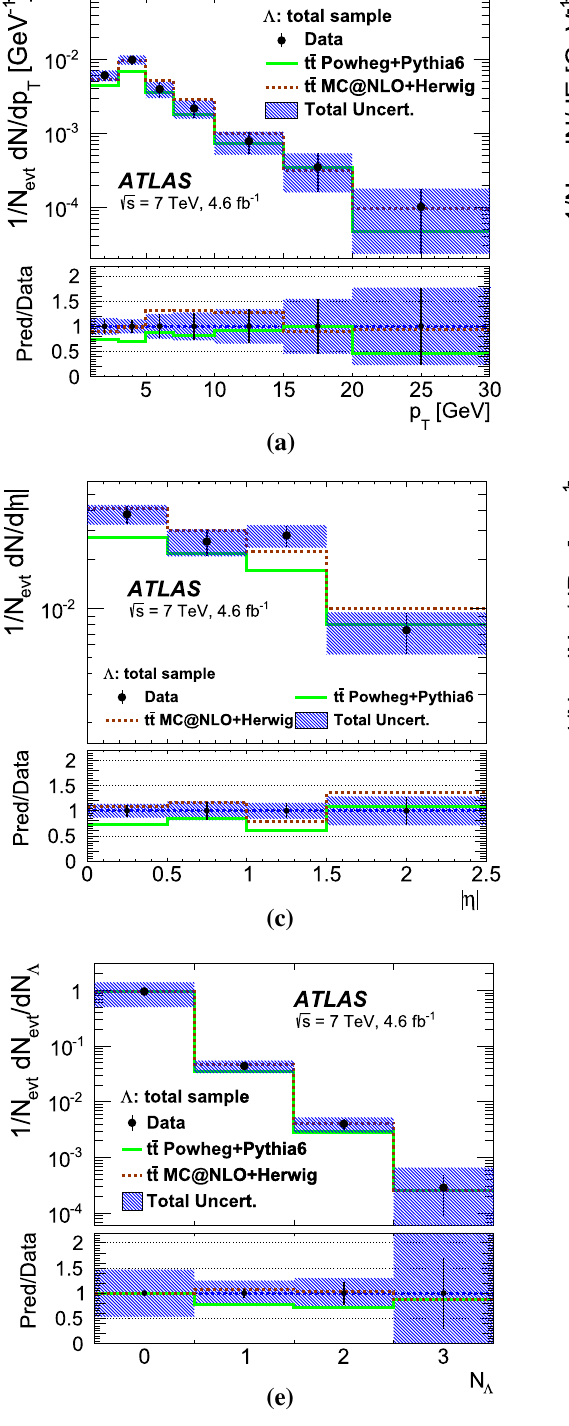
Fig. 6 Kinematic characteristics for the total (cid:3) production, for data and detector-level MC events simulated with the Powheg + Pythia6 and MC@NLO + Herwig generators. Total uncertainties are represented by the shaded area. Statistical uncertainties for MC samples are negligible in comparison with